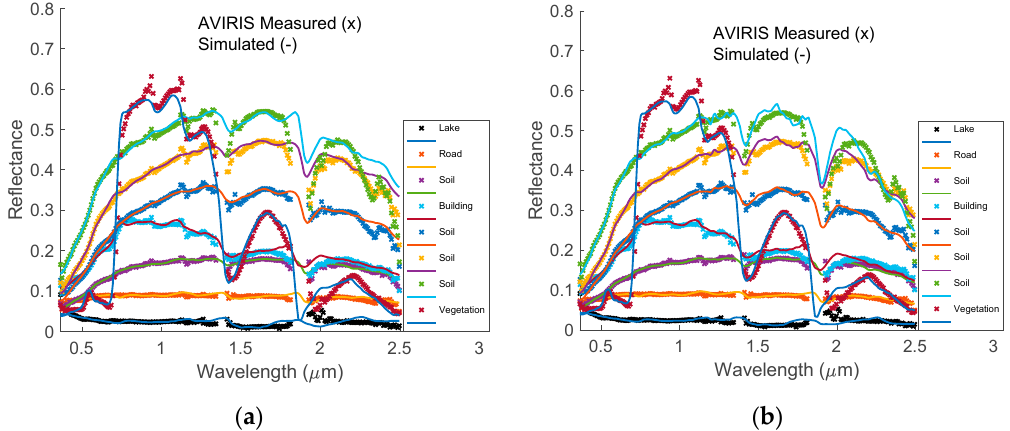
Figure 12. ( a ) Randomly selected reflective spectra measured by AVIRIS instrument (x) and the corresponding simulated spectra (-) using HSBR model with 7 hinge wavelengths. The big differences occur at water absorption bands and in region with wavelength larger than 2.25 μ m; ( b ) Selected reflective spectra measured by AVIRIS instrument (x) as shown in ( a ) and the corresponding simulated spectra (-) using HSBR model with 8 hinge wavelengths. The fit in long wavelength range is greatly improved. The noisy AVIRIS measured reflectances in the region from 1.353 μ m to 1.412 μ m and region from 1.821 μ m to 1.927 μ m are not shown in these plots. By using 8 or more hinge wavelengths in our HSRB model, we can fill these spectral gaps using spectral correlation information contained in the HSRB principal components.